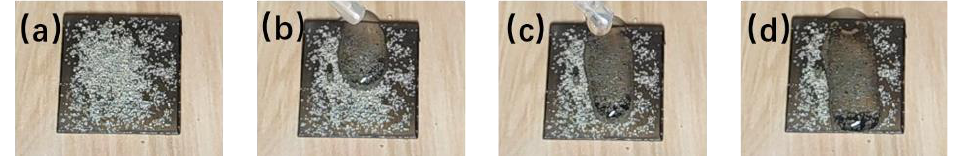
Figure 13. Cleaning process of Q235 steel surface: ( a ) sand was spread on the surface of Q235 steel surface, ( b ) water drops on the surface of Q235 steel, ( c ) water flowing over the surface of Q235 steel sprinkled with sand, and ( d ) large amount of sand still on the surface of Q235 steel. To further demonstrate the good self-cleaning properties of superhydrophobic surfaces, four surfaces with different wettabilities were tested. The microstructure was made of MTMS and micron-scale ZnO, and the CA was about 132.7 ◦ . The nanostructure was made of MTMS and nano SiO 2 , and the CA was about 141.5 ◦ . The superhydrophobic hierarchical structure was made of MTMS, nano SiO 2 , and micron ZnO, and the CA is about 153.9 ◦ . The water cleaning test was carried out for 1.5 min (water quantity, 10 mL) with nearly zero kinetic energy of droplets. The self-cleaning efficiencies of surfaces with different wettabilities are shown in Figure 14. Most particles (90–95%) remained on the Q235 steel surface. About 50–65% particles remained on the microstructure surface, and 35–55% particles remained on nanostructure surface. Most particles were removed from the hierarchical structured surfaces, but approximately 15–25% of particles remained. This result is generally consistent with the previously reported literature [52]. The analysis results show that the self-cleaning efficiency increases with an increasing surface CA.